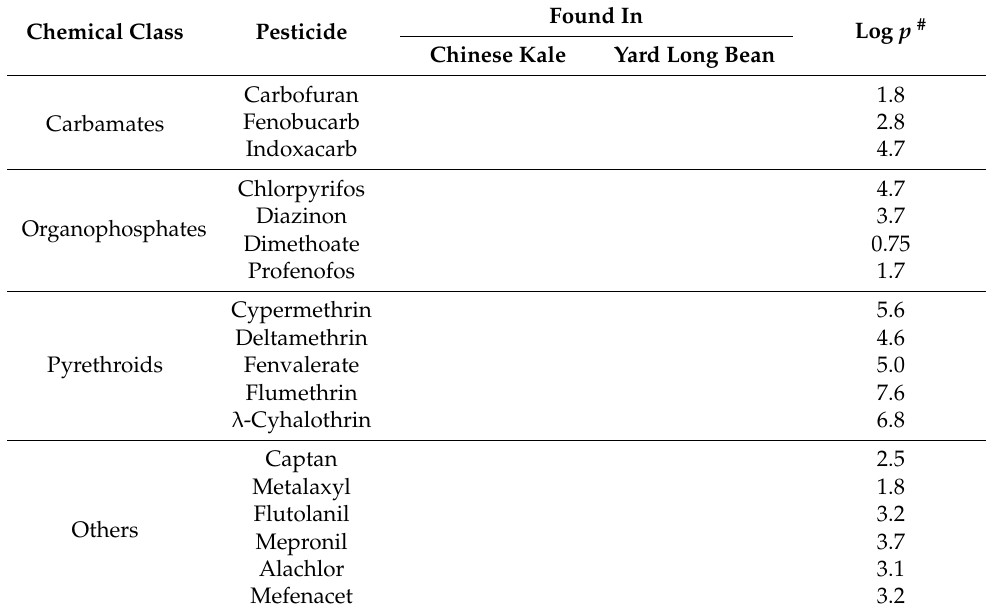
Table 5. Pesticides found in Chinese kale and yard long bean, and their lipophilicity as reflected by Log p (partition coefficient)